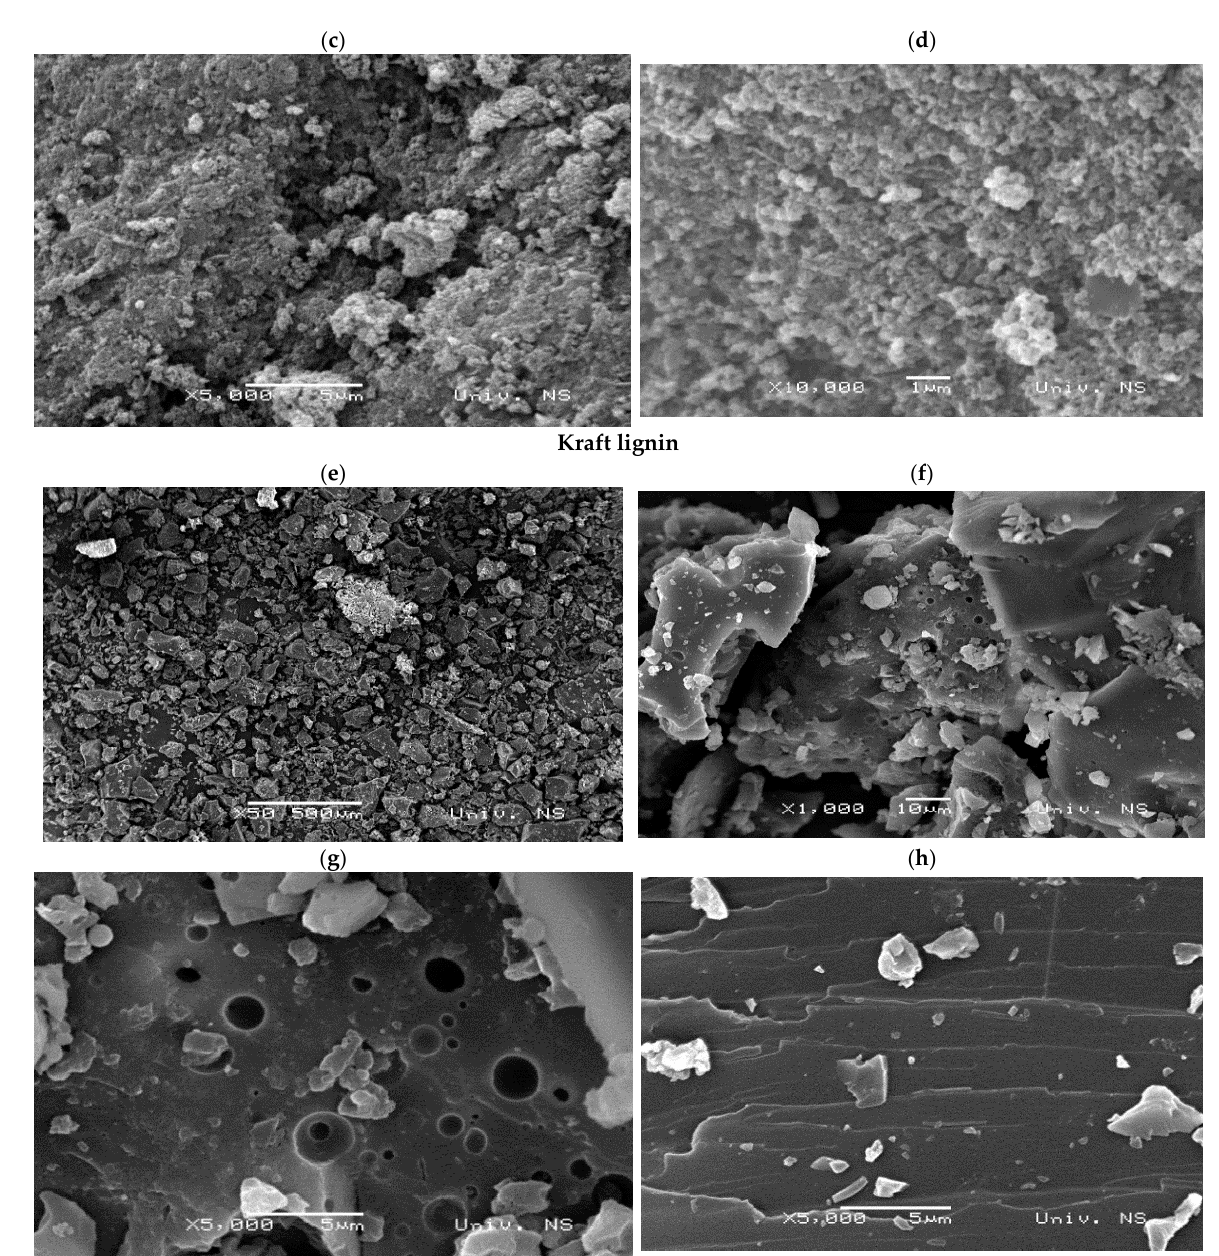
Figure 4. Eucalypt stump and Kraft lignins were observed by scanning electron microscopy. Mag-